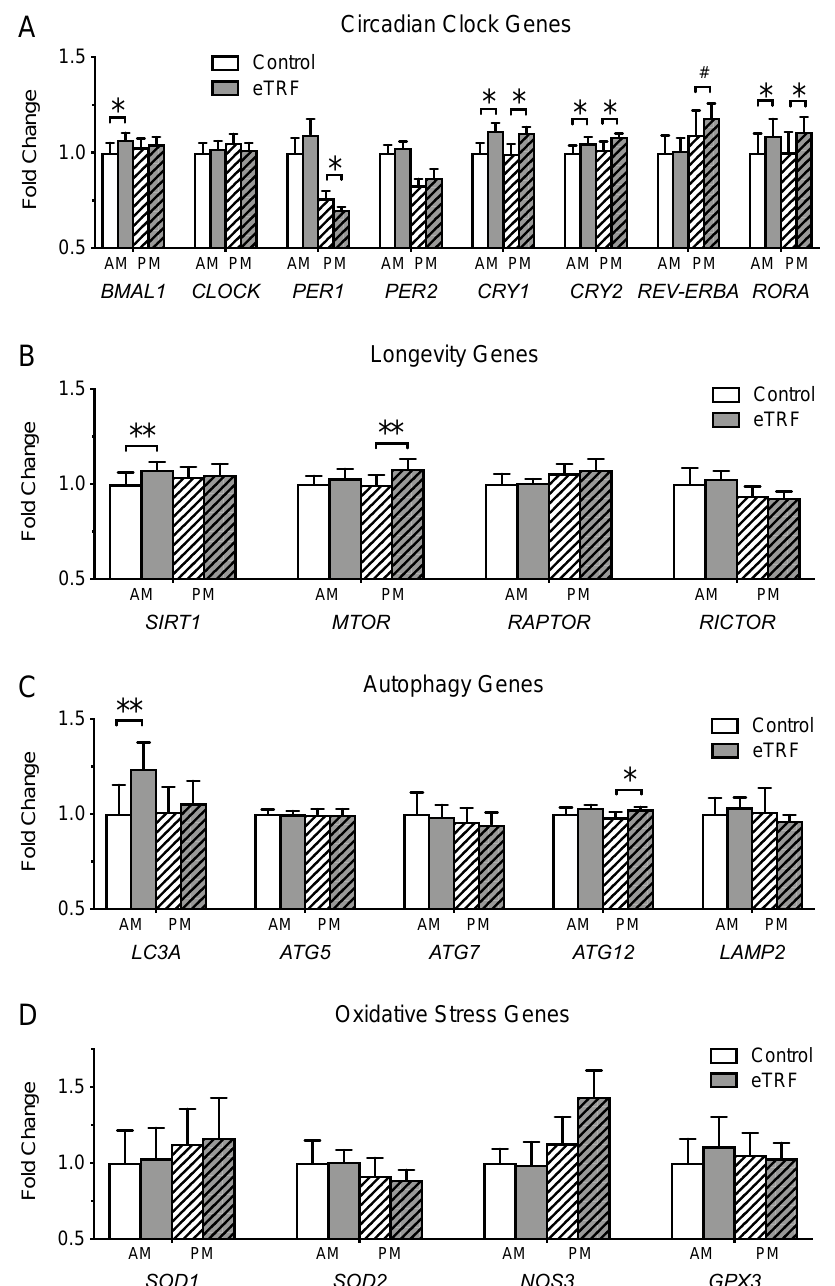
Figure 6. Gene Expression in Whole Blood. ( A ) Early time-restricted feeding (eTRF) changed the expression of several circadian clock genes, including BMAL1 , PER1 , CRY1 , CRY2 , REV-ERBA, and RORA in the morning (AM) and/or evening (PM). It also increased the expression of ( B ) the longevity genes SIRT1 in the morning and MTOR in the evening. ( C ) The autophagy genes LC3A and ATG12 were elevated in the morning and evening, respectively, although the latter was no longer significant after adjustment for multiple comparisons. ( D ) The expression of oxidative stress genes was unaffected . Genes in panel A were pre-specified outcomes, while genes in panels B – D were exploratory and had their p-values adjusted for multiple comparisons. # p < 0.10 (applied only to pre-specified genes in panel A ), * p < 0.05, ** p < 0.007 (significant after adjustment for multiple comparisons, applied only to exploratory genes in panels B – D ) .